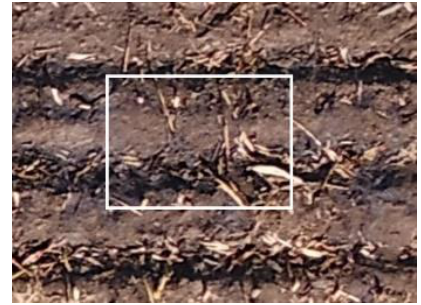
Figure 7. Original straw image with the height of 30 m.